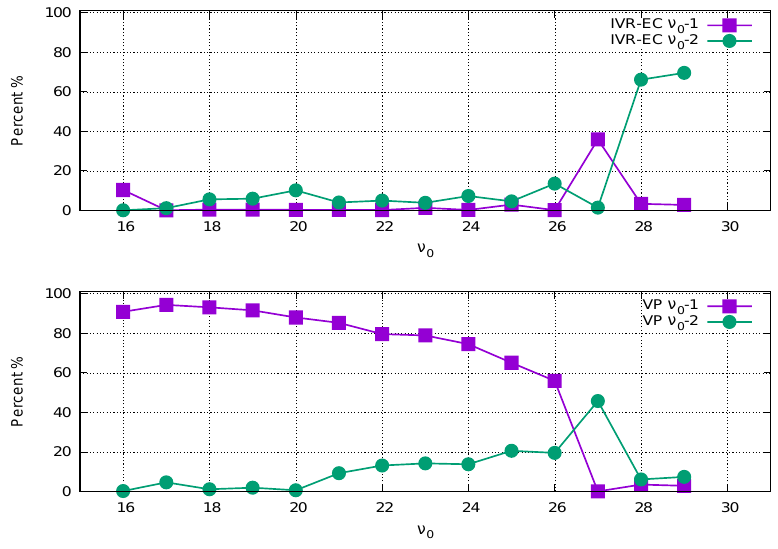
Figure 5. Path followed (statistically) for each vibrational